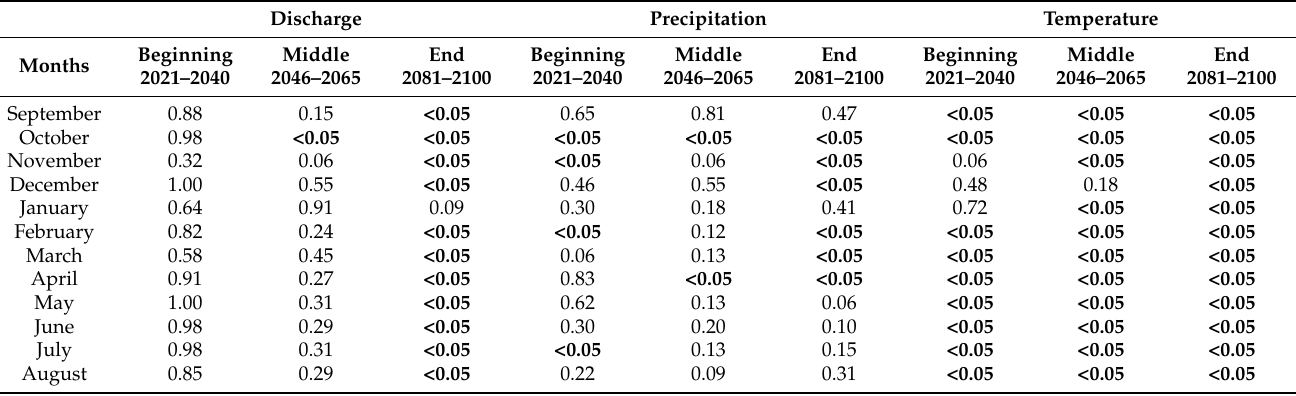
Table 4. Summary of the significance levels ( p -values) of the Wilcoxon rank-sum test for the discharge, precipitation and temperature during the three projection periods (beginning of the century, middle of the century and end of the century) compared to the reference period (baseline). Significant p -values ( ≤ 0.05) are in